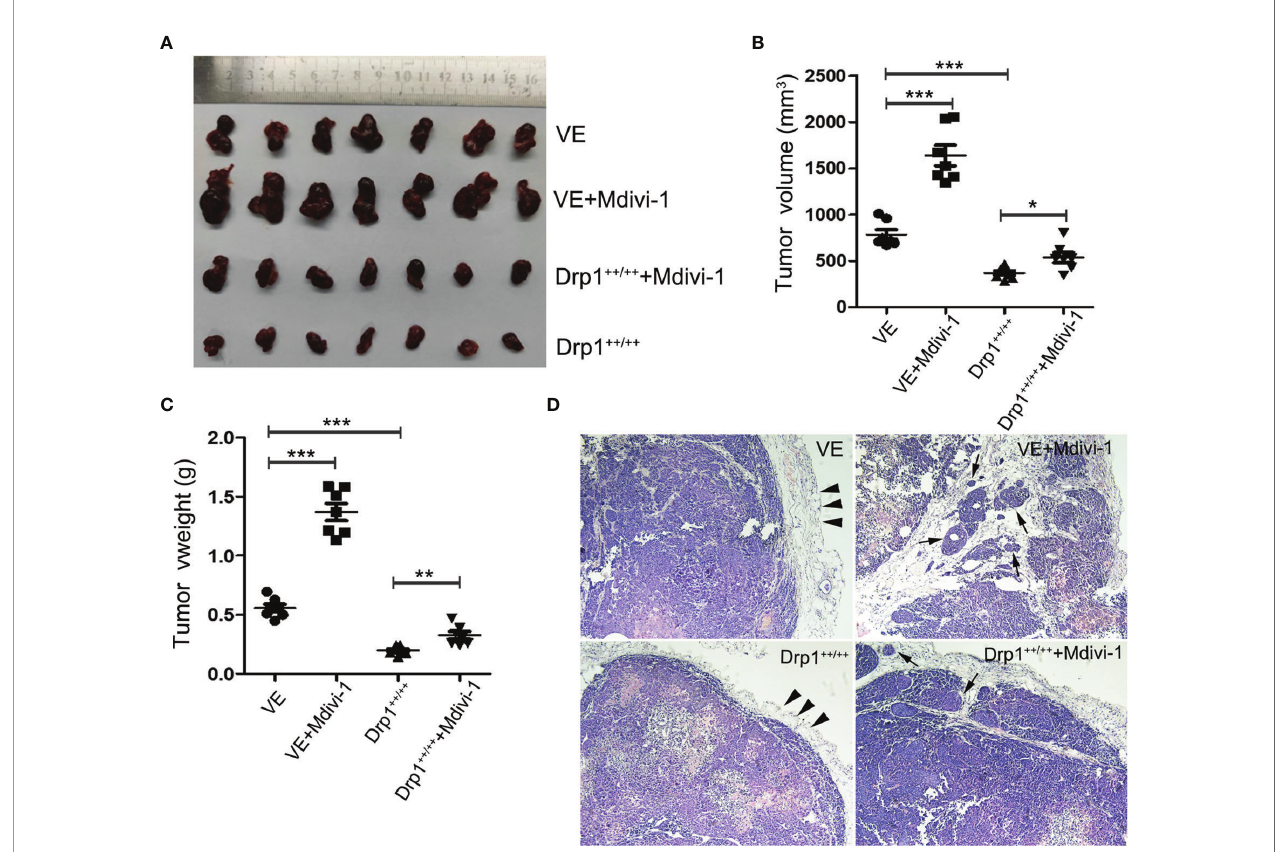
FIGURE 6 | Inhibition of Drp1 promoted the growth and invasion of GH3 cells in vivo . (A) Excised tumors in four groups (VE, VE+Mdivi-1, Drp1 ++/++ , Drp1 ++/++ +Mdivi-1) were shown. (B) Tumor volume in different groups. (C) Tumor weight in different groups. (D) HE staining of tumor(×100 magni fi cation). Smooth tumor capsule (arrowheads) was detected in VE and Drp1 ++/++ group. Tumor nodules (arrows) were detected in tumor capsule in VE+Mdivi-1 and Drp1 ++/++ +Mdivi-1 group. *P < 0.05, **P < 0.01, ***P <